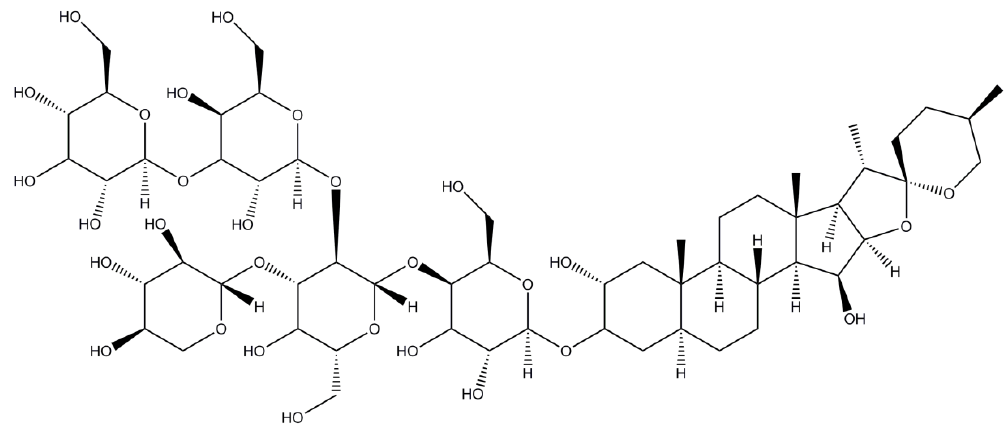
Figure 12. Structure of digitonin (chemical formula is C₅₆H₉₂O₂₉).